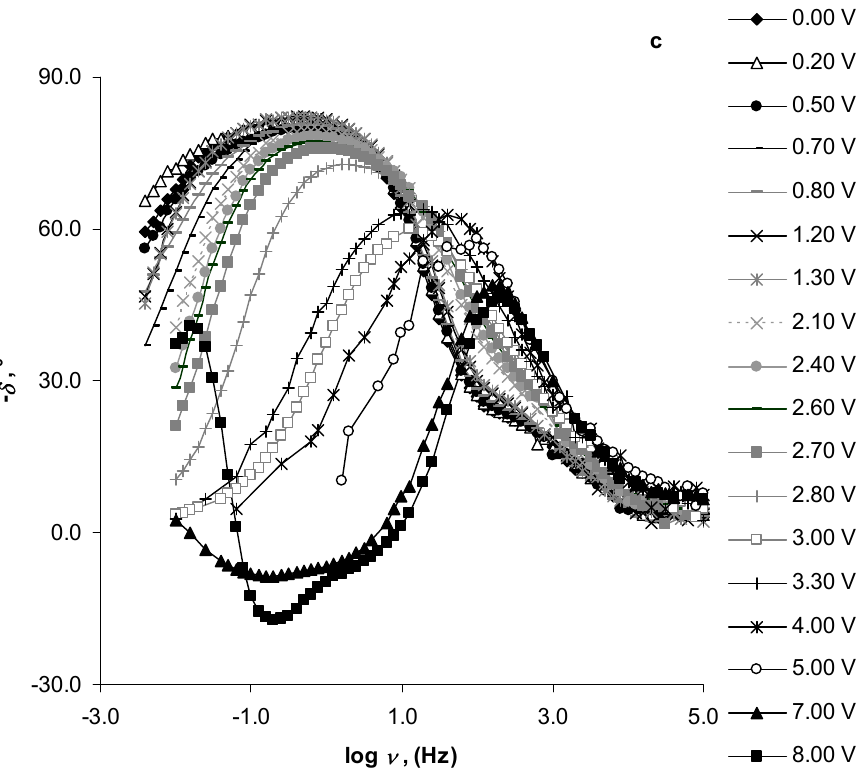
Figure 5. Bode plots for the N4111(TFSI)|Al/Al 2 O 3 system measured at fixed Al-electrode potentials noted in the figures: log | Z ′′| vs. log ν ( a ); log | Z | vs. log ν ( b ), and − δ vs. log ν ( c ). Log | Z | vs. log ν plots were linear in the log ν range from − 2.40 to 1.60 (Hz) and in the potential range from 0.00 V to 2.40 V with a slope of –0.88 (Figure 5b). However, at E ≥ 2.40 V it started to bend, and at the lowest frequencies it formed a plateau, indicating that the N4111(TFSI)|Al/Al 2 O 3 system entered the mixed kinetic region. As the Al-elec- trode potential increased, the plateau started to form at higher frequencies and had a lower log | Z | value. The log | Z | vs. log ν plot, measured at E = 7.0 V, had a log |Z| plateau that started to form at log ν ≤ 1.60 (Hz), obtaining a log |Z| maximum at log ν = 0.95 (Hz), and then started to continuously decrease with a very small slope at lower frequencies (Figure 5b). The log | Z | vs. log ν plot, measured at E = 8.0 V, also started to form a log | Z | plateau at E ≤ 1.60 (Hz); however, since it passed a log | Z | maximum at log ν = 1.09 (Hz), the values of log | Z | started very slowly to reduce again. At log ν = − 0.6 (Hz) the reduction intensified and formed a minimum (log | Z | = 2.97) at log ν = −1.30 (Hz) (Figure 5b). The minimum formed at the E = 8.0 V measured log | Z | vs. log ν plot’s low-frequency section overlapped with the low-frequency inductive loop and the start of a new semi-circle (vis- ible in the Nyquist plot, Figure 4c), indicating the presence of a slow reorganisation pro- cess at the N4111(TFSI)|Al interface.